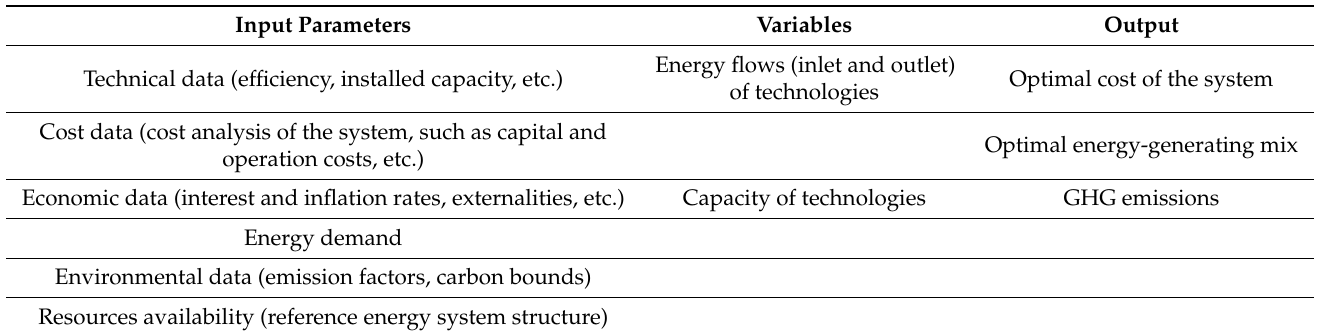
Table 2. Model organization [24].